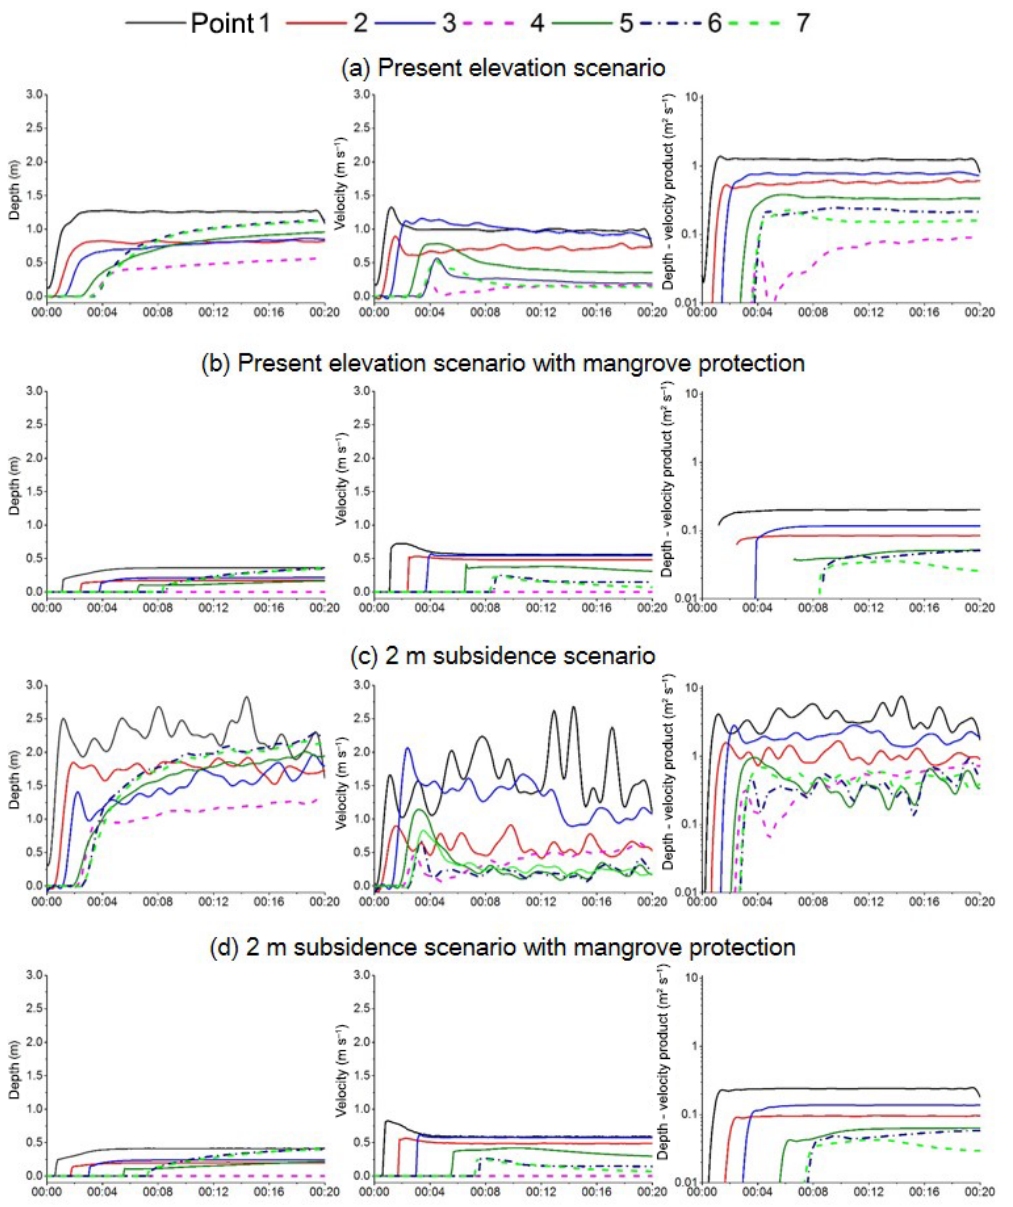
Figure 8. Simulated water depth (left), velocity (centre), and the depth–velocity product (right) at seven locations along the small paths shown in Fig. 7. (a) Present elevations, which were reproduced based on the authors’ survey. (b) Present elevations with a 20m mangrove belt, (c) 2m land subsidence scenario, and (e) 2m land subsidence scenario with a 20m mangrove